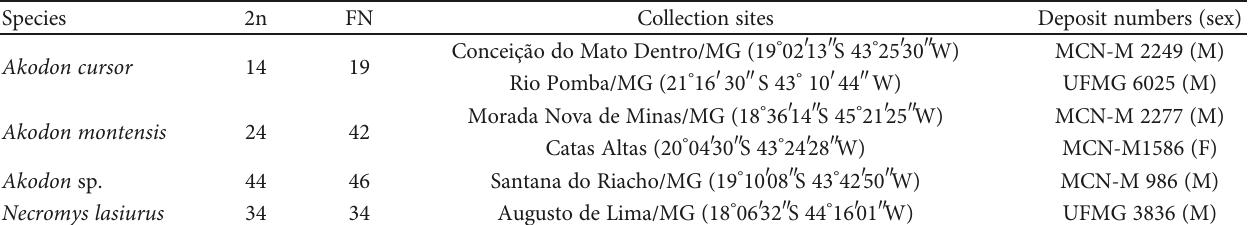
Table 1: Specimens analyzed.